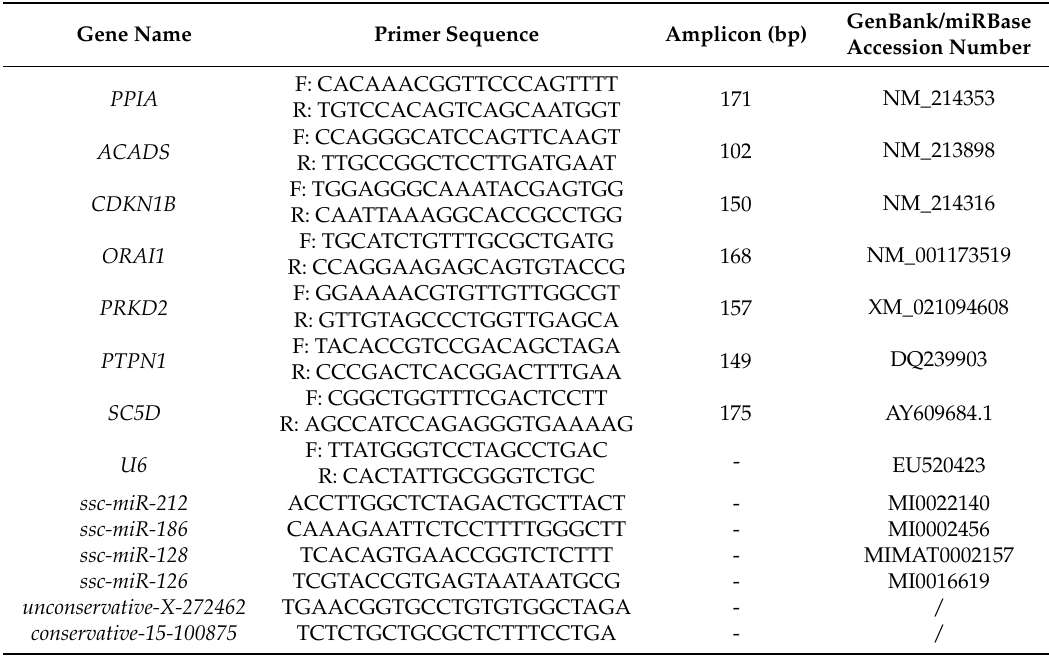
Table 3. Primer information of selected miRNAs and mRNAs for qRT-PCR